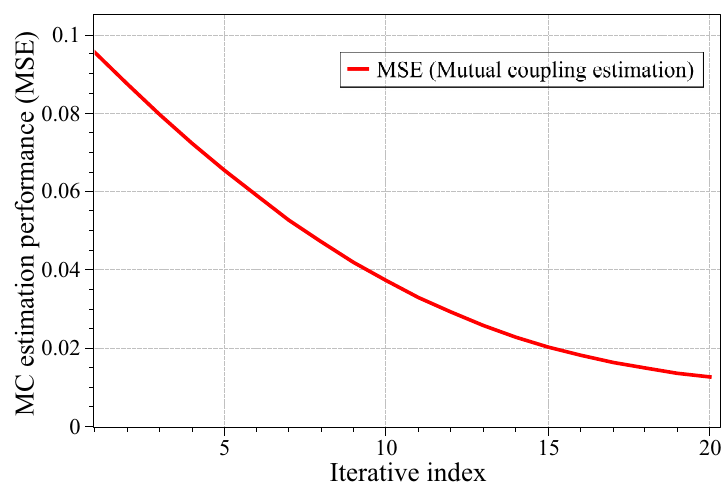
Figure 2. The estimation performance for mutual coupling coefficients.